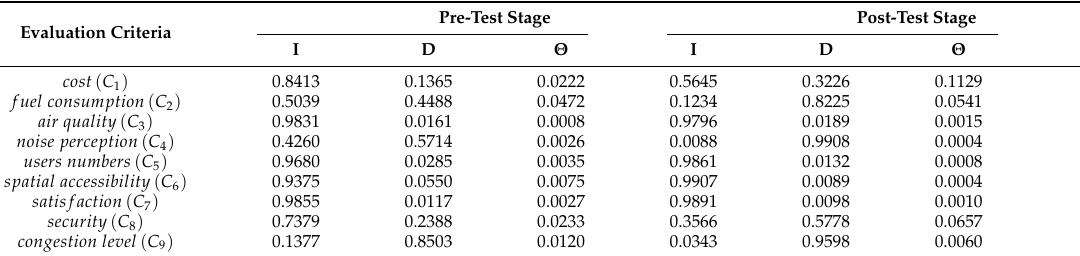
Table 6. The aggregated BPA results for nine criteria.